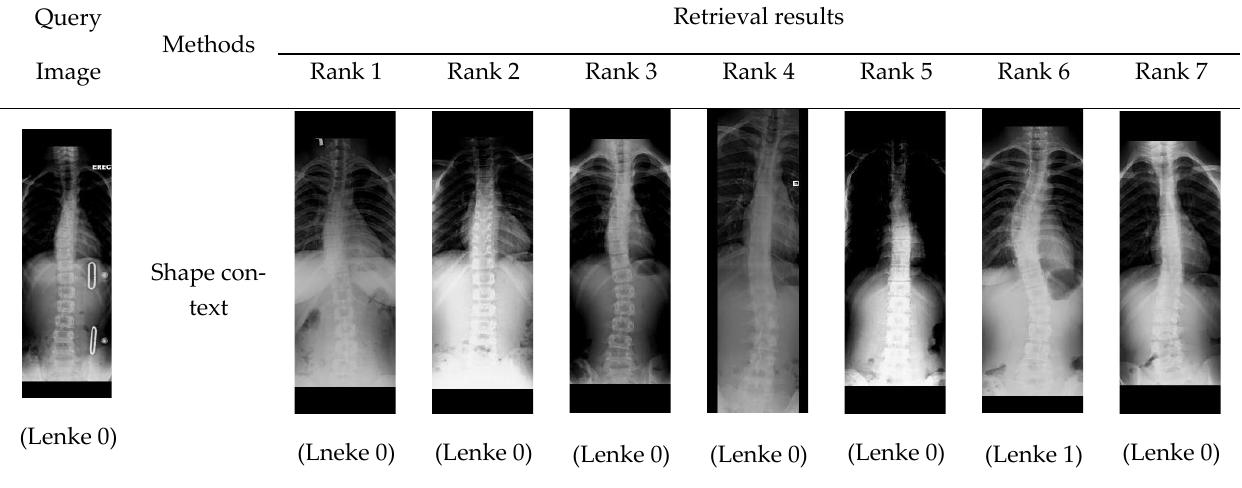
Figure 16. Image retrieval example for different shape descriptors with the query of Lenke 4.